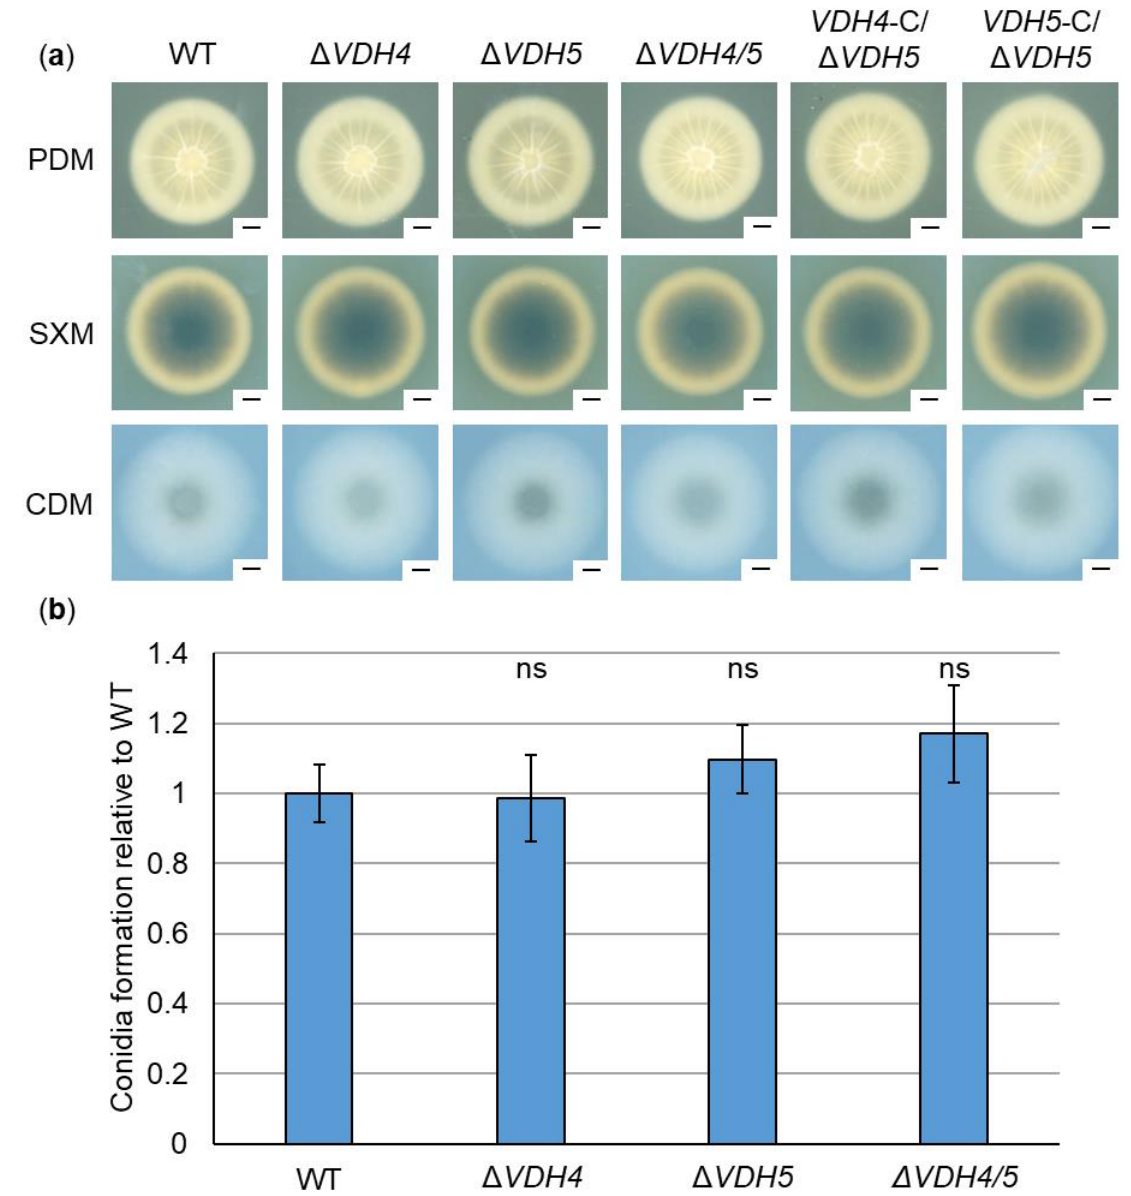
Figure 3. Ex-planta growth, microsclerotia formation and conidiation of V. dahliae do not depend on the presence of hydrophobin-encoding genes VDH4 and VDH5 . JR2 wild-type (WT) was compared with VDH4 ( ∆ VDH4 ) and VDH5 ( ∆ VDH5 ) single deletion strains, VDH4/5 double deletion strain ( ∆ VDH4/5 ), and VDH4 ( VDH4 -C/ ∆ VDH5 ) or VDH5 ( VDH5 -C/ ∆ VDH4 ) single gene complementation strains in the double deletion strain background. ( a ) Potato dextrose medium (PDM), simulated xylem medium (SXM) and Czapek-Dox medium (CDM) plates were point-inoculated with 50,000 spores of the respective strains and incubated at 25 ◦ C for ten days. Scans from below depict similar morphology of wild-type, ∆ VDH4, ∆ VDH5 , ∆ VDH4/5 , VDH4 -C, and VDH5 -C on all media tested (scale = 0.5 cm). ( b ) Conidia formation was quantified in five-day-old cultures in liquid SXM incubated at 25 ◦ C with constant agitation after inoculation of 4000 spores per ml. Error bars represent standard deviations of the means, and significant differences from wild-type were calculated using Welch’s t -tests. The experiment was performed two independent times, each time with two biological replicates ( n = 4) and three technical replicates. No difference (ns, not significant) was detected in the ability to form conidiospores between VDH4 and VDH5 single deletion strains, the VDH4/5 double deletion strain, and the wild-type strain.